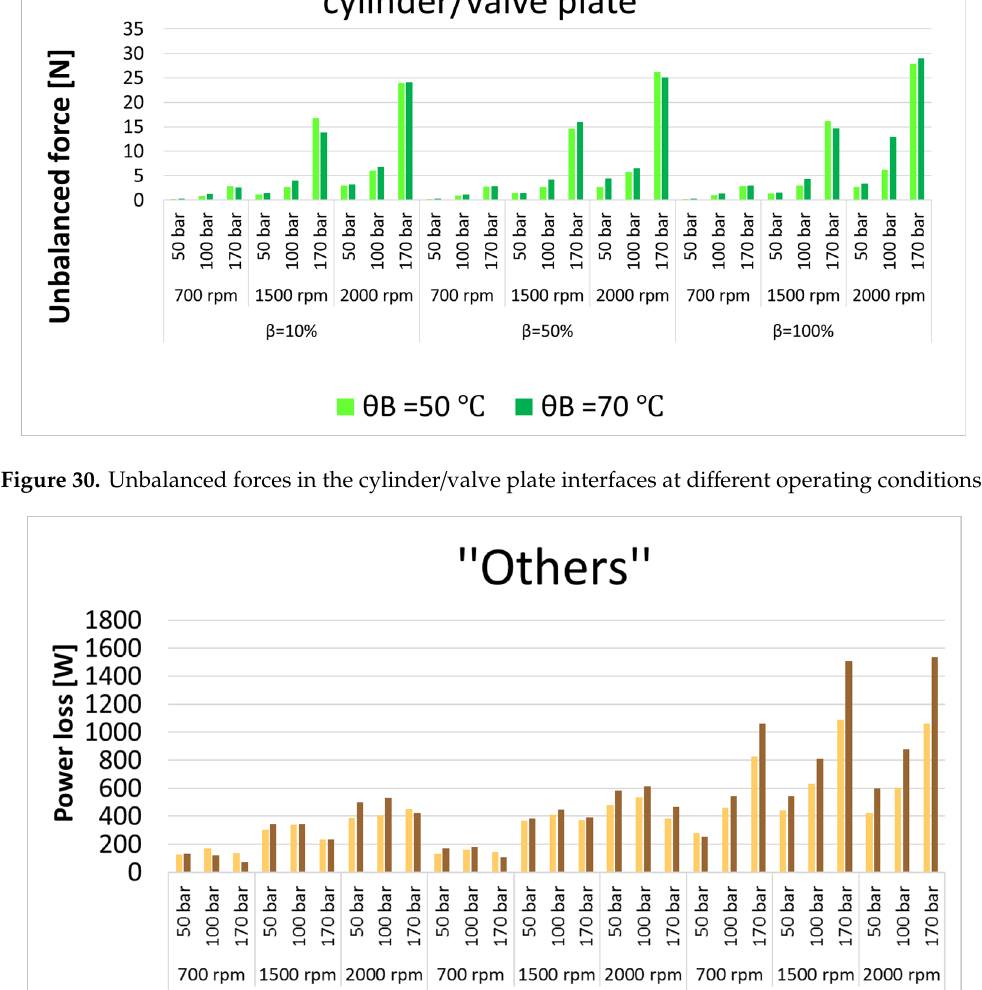
Figure 29. Unbalanced forces in the piston/cylinder interfaces at different operating conditions.